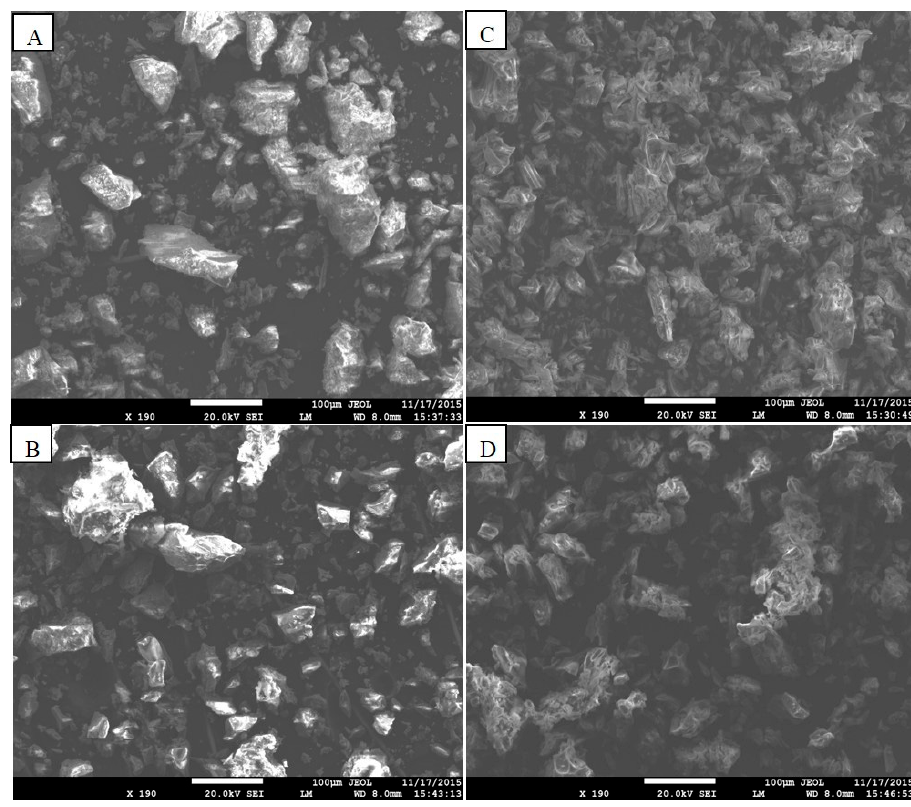
Figure 2. SEM images of ( A ) red scoria, ( B ) Ch–Rs, ( C ) pumice, and ( D ) Ch–Pu.